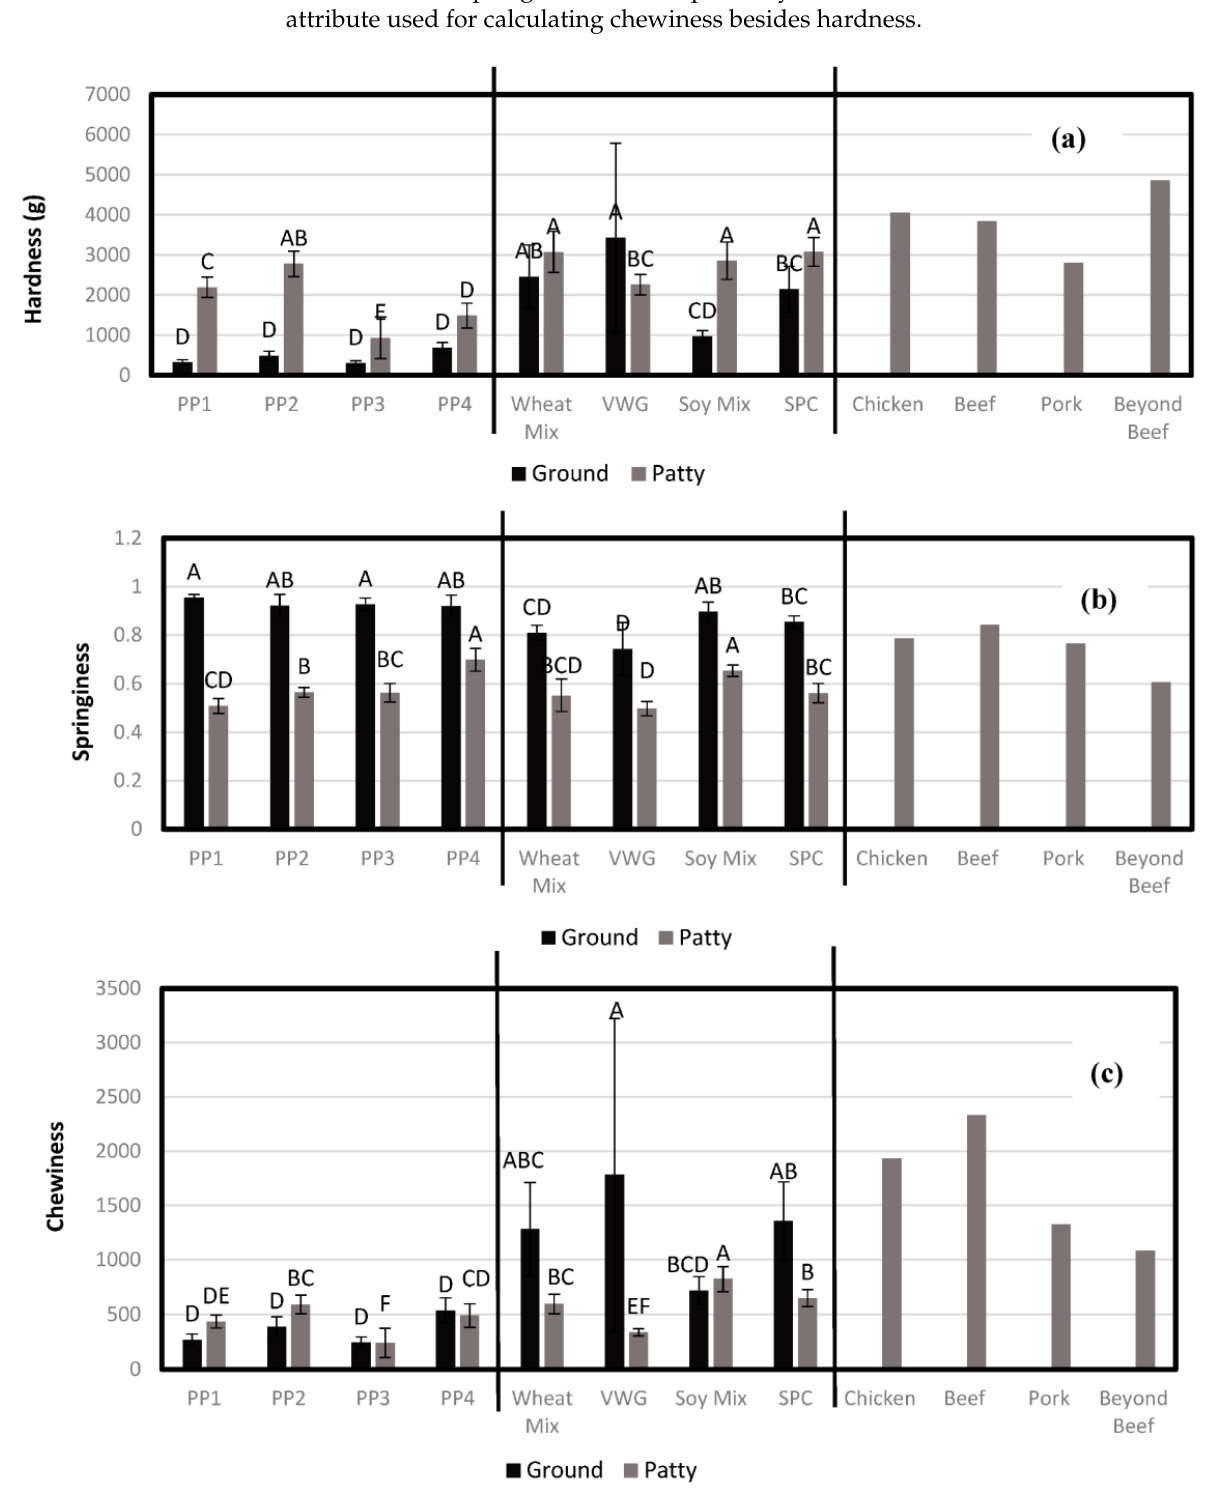
Figure 15. Mean hardness ( a ), springiness ( b ), and chewiness ( c ) of ground extrudate and patties made from the ground extrudate. Bars of the same color denoted by the same letter are not significantly different ( p < 0.05).